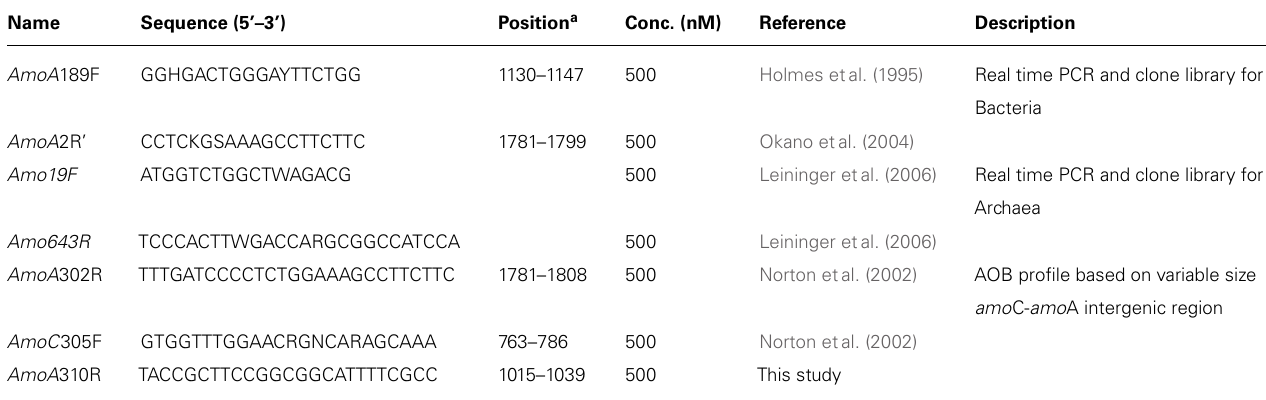
Table 1 | Primers used in this study for a real time PCR assay of amoA , amplification of the intergenic region between amoC and amoA , and development of amoA clone libraries from soil DNA.